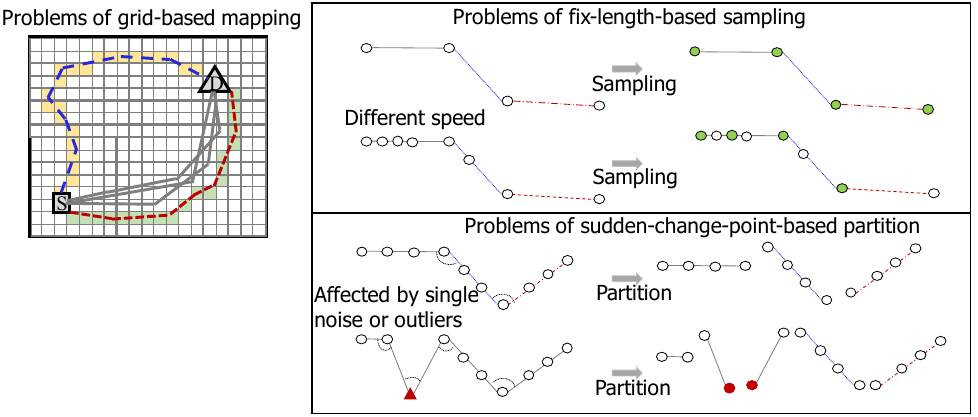
Figure 3. Problems of different pre-processing methods. ( Top left ) Grid-based: both blue and red dash trajectories were represented by a series of cells which are visited for one time; hence, they were easier to be detected as outliers, while a red dash trajectory was actually a normality. ( Top right ) Sampling-based: two trajectories recorded on the same road but with different recording frequencies or different traveling speeds of the moving objects would lead to different sampling results shown as green points. ( Bottom right ) Partitioning-based: a noise or an outlier shown as the red triangle would produce different partitioning